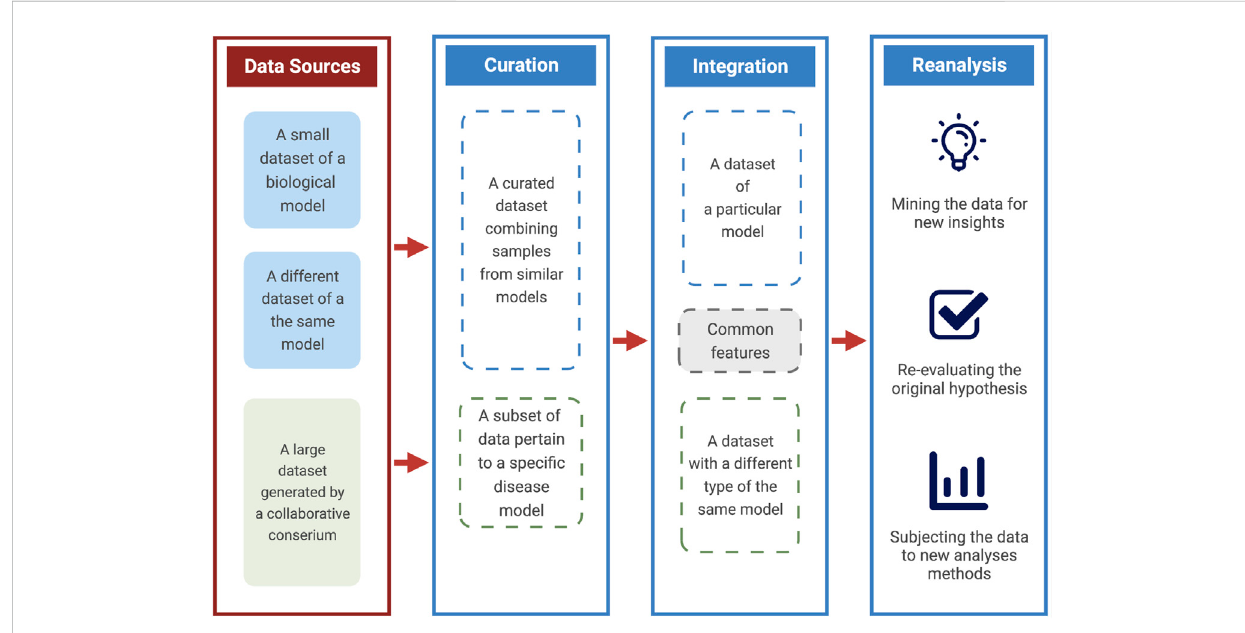
FIGURE 1 A scheme for maximizing the utility of public data. A diagram explaining the ways and bene fi ts of using data from public sources. These include curating datasets of particular models, integrating different data types, and re-analysis with various